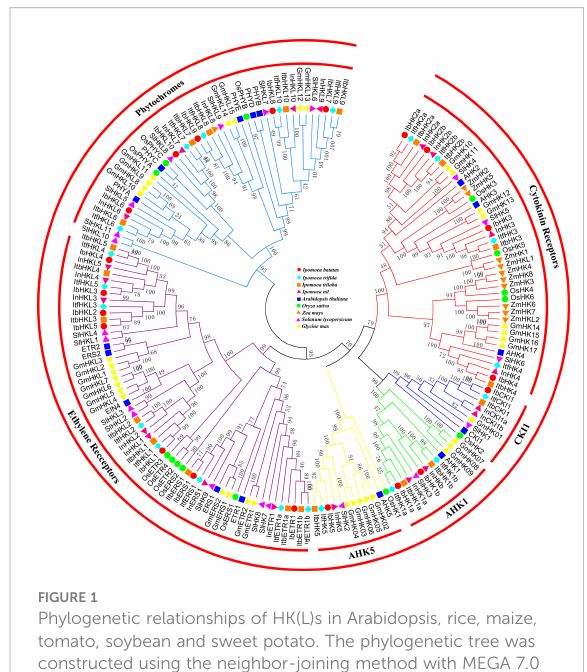
FIGURE 2 Phylogenetic relationships of HPs in Arabidopsis, rice, maize, tomato, soybean and sweet potato. For other details, see Figure 1.